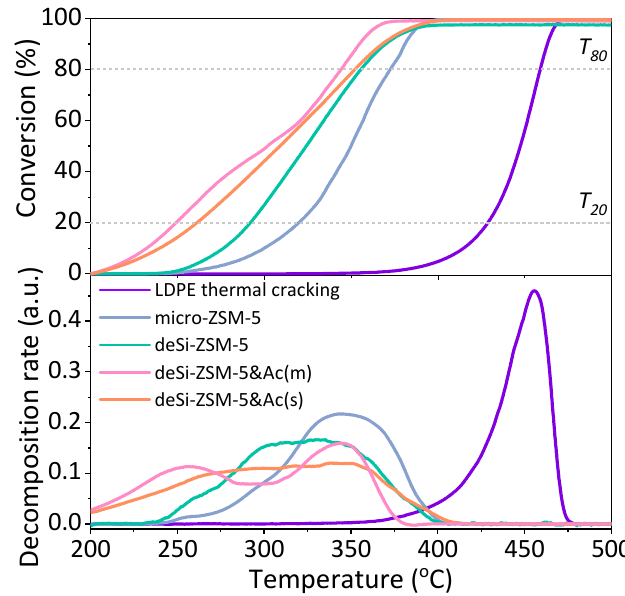
Figure 1. ( Upper ) LDPE (low-density polyethylene) catalytic cracking conversion curves ( T 20 and T 80 the temperatures necessary for reaching 20% and 80% conversion) and ( lower ) decomposition rates of the studied zeolites as a function of temperature.